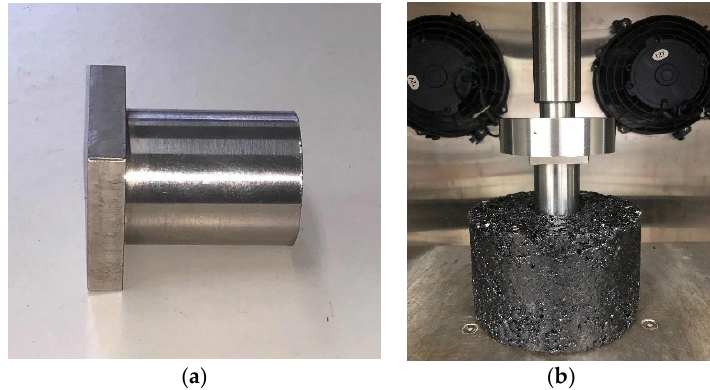
Figure 5. Uniaxial penetration shear test: ( a ) plunger; and ( b ) experimental setup.